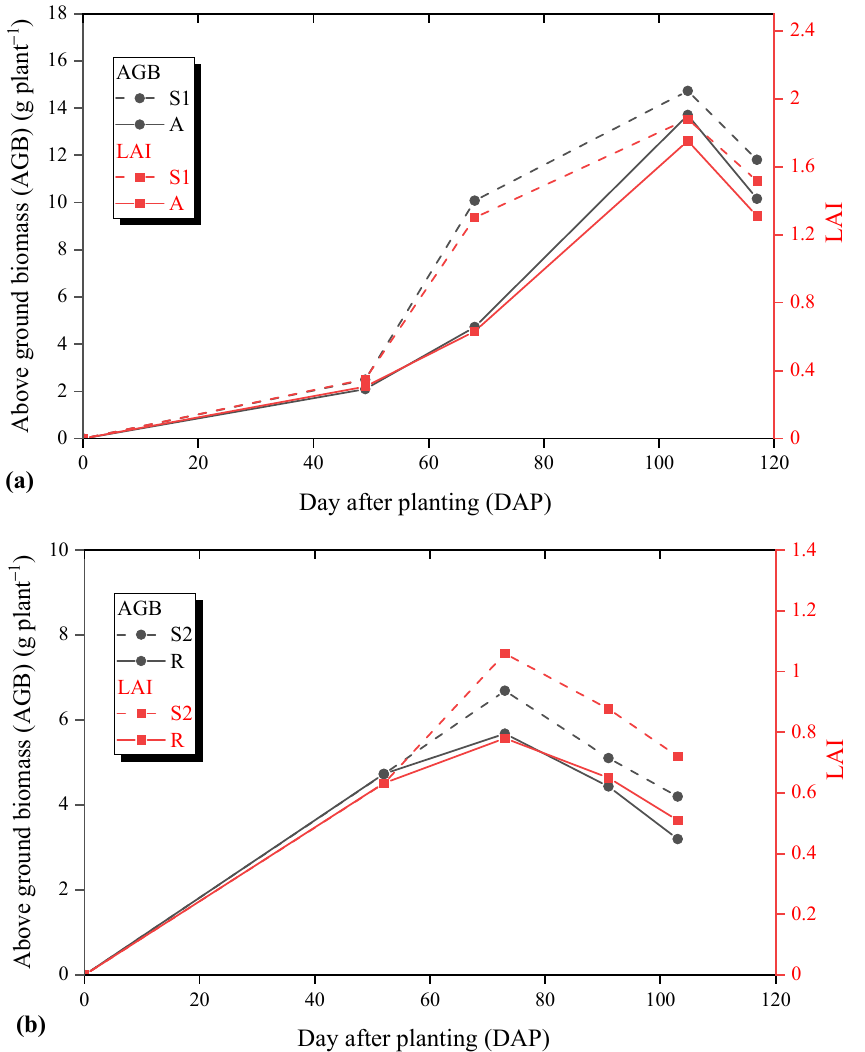
Figure 10. The time evolution of LAI and AGB for the potato under different treatments in first season ( a ) and second season ( b ).